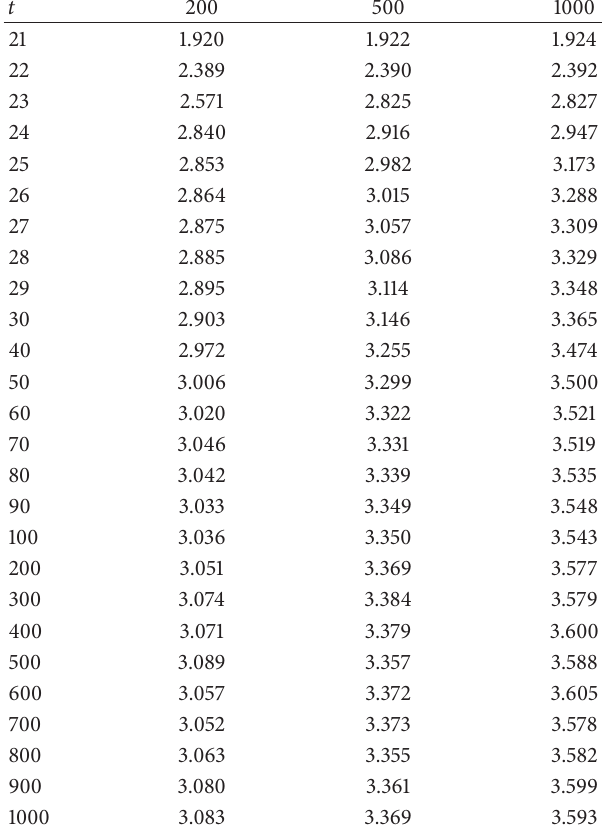
Table 1: Values of the threshold sequence ℎ 𝑡 corresponding to ARL 0 of 200, 500, and